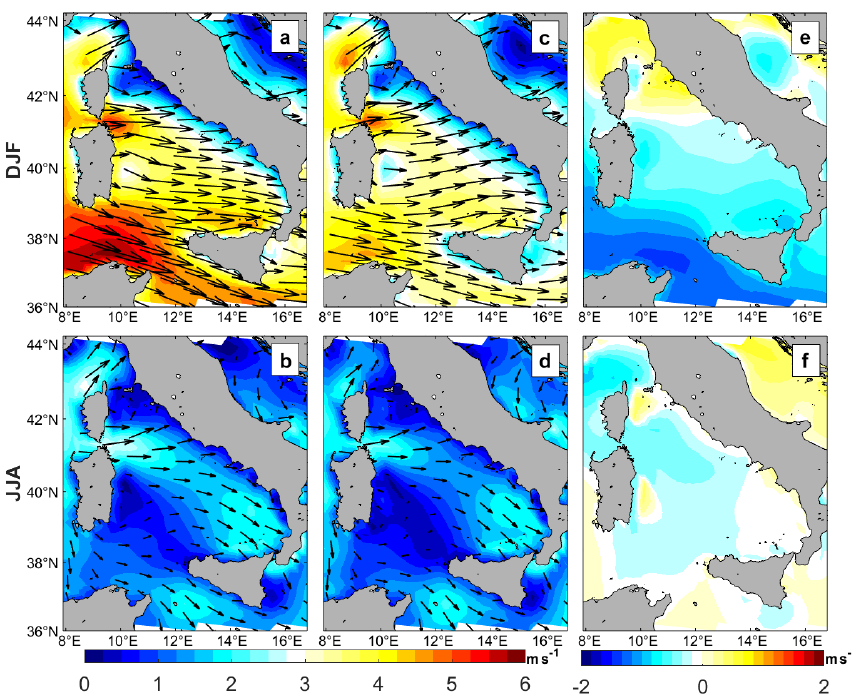
Figure 10. Winter (a, c, e) and summer (b, d, f) averages of the wind speed module (colors, ms − 1 ) and direction (arrows) for present (a, b) and future (c, d) climate as computed from ROM. Differences between the wind speed module in the future and present climate are shown in panels (e) and (f)